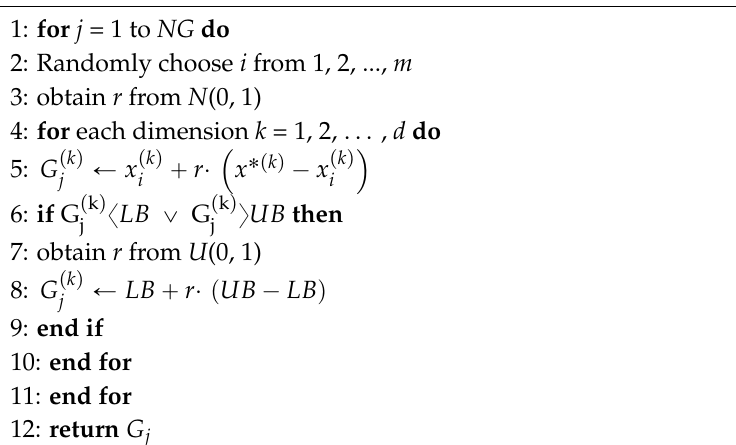
Algorithm 2 Generating Gaussian